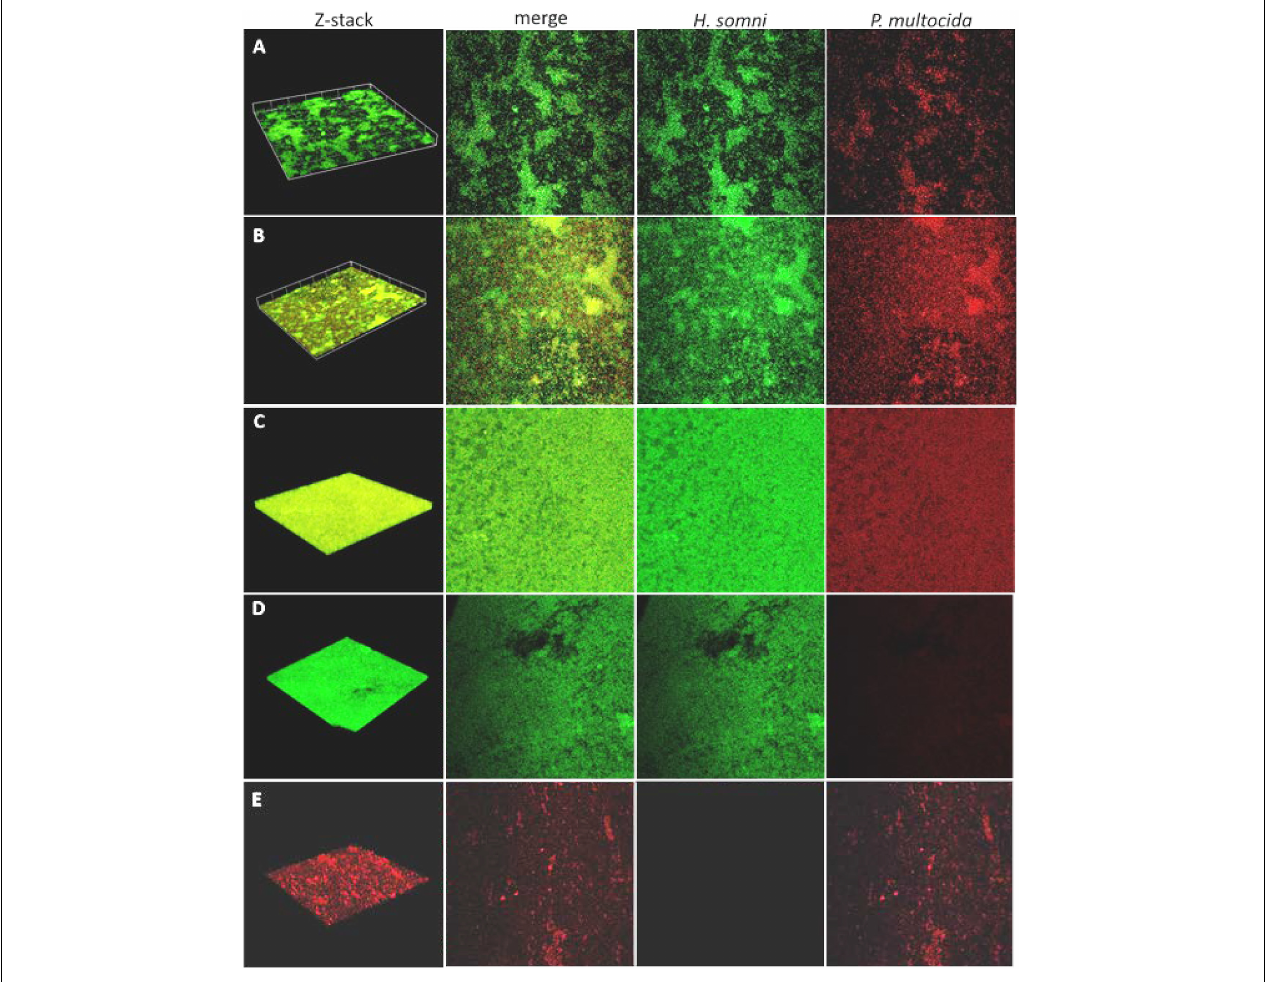
FIGURE 1 | Fluorescence in situ hybridization (FISH) of polymicrobial and single species biofilms. Biofilms were imaged over a 48-h period by CLSM after FISH using probes labeled with fluorescein for H. somni or Cy5 for P. multocida . (A–C) , 6-h, 12-h, and 48-h time points, respectively, for biofilms containing H. somni strain 2336 and P. multocida strain C0513-P5. Each column shows the 3-D z-stack, a merged view of images with each probe, the probe for only H. somni strain 2336, and the probe for only P. multocida strain C0513-P5. (D) Single species biofilm of H. somni strain 2336 after 48 h showing in each column the 3-D z-stack, the merged view of images with each probe, the probe for only H. somni strain 2336, and the probe for only P. multocida strain C0513-P5. (E) A single species biofilm of P. multocida strain C0513 after 48 h showing in each column the 3D z-stack, the merged view of images with each probe, the probe for only H. somni strain 2336, and the probe for only P. multocida strain